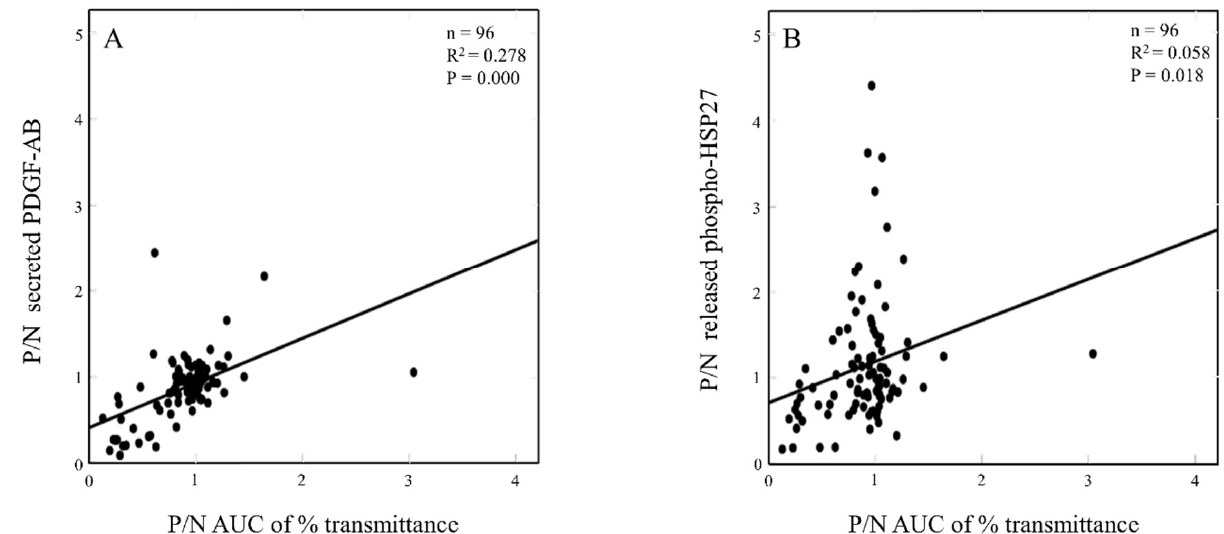
Figure 4. The relationship in the individual A β -effects between aggregation and secreted PDGF-AB or released phosphorylated HSP27 in TRAP-stimulated human platelets of DM patients. We indicated individual A β -effect on the TRAP-stimulated platelets of each parameter as a calculated ratio, A β -positive/A β -negative (P/N) and plotted the individual P/N AUC of % transmittance in platelet aggregation against P/N secreted PDGF-AB ( A ) or P/N released phosphorylated HSP27 ( B ) induced by TRAP stimulation in the platelets of type 2 DM patients, respectively. The data from 96 subjects were plotted and analyzed by linear regression analysis.